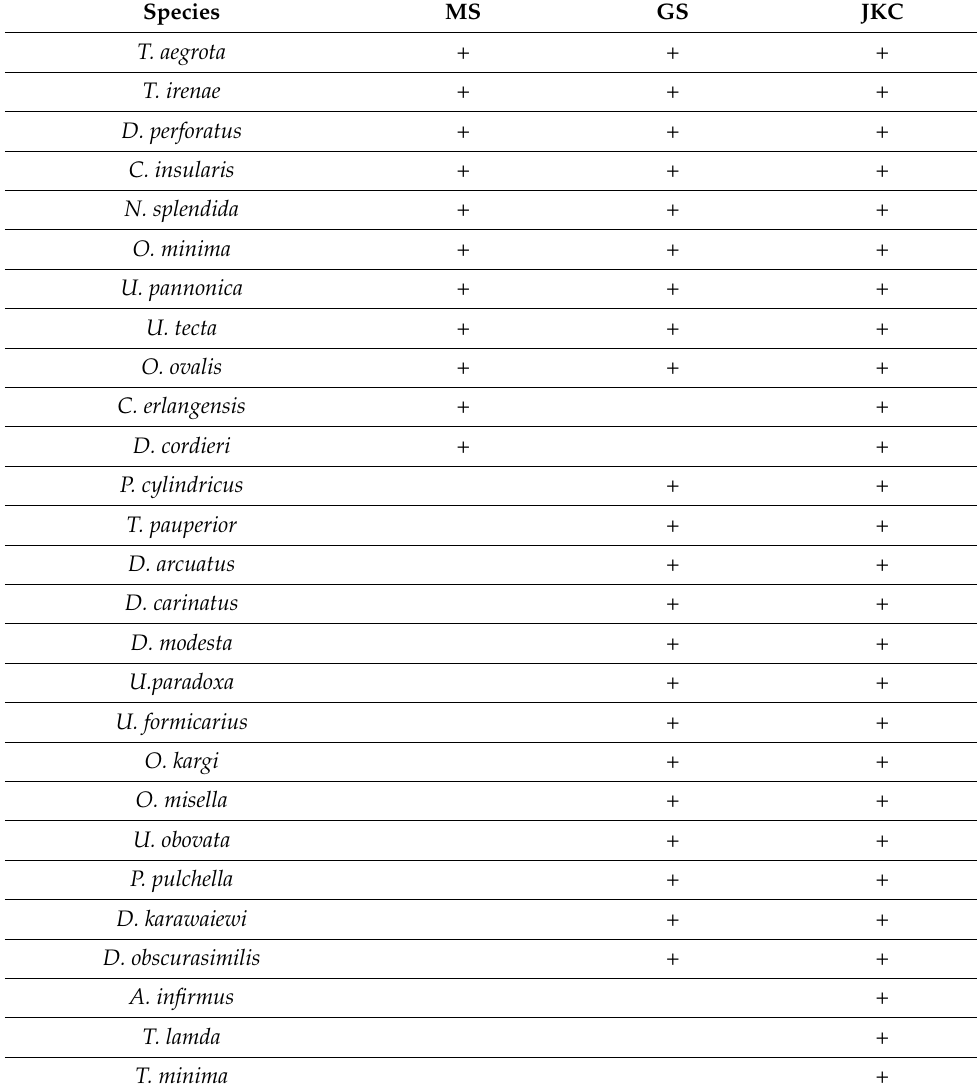
Table 2. Uropodina species found on nunataks in Poland; MS—´Sl˛e˙za Massif, GS—´Swi˛etokrzyskie Mountains, JKC—Jura Krakowsko-Cz˛estochowska. Species MS GS